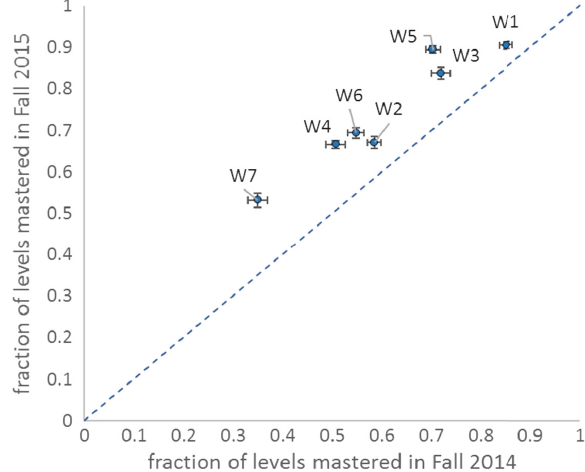
FIG. 6. Average student mastery rates through semester by week: Both axes are the average fraction of levels mastered in each week, in 2014 and 2015. Points above the line indicate improved mastery rates for 2015 over 2014. This plot includes only students who attempted all levels, or all levels except